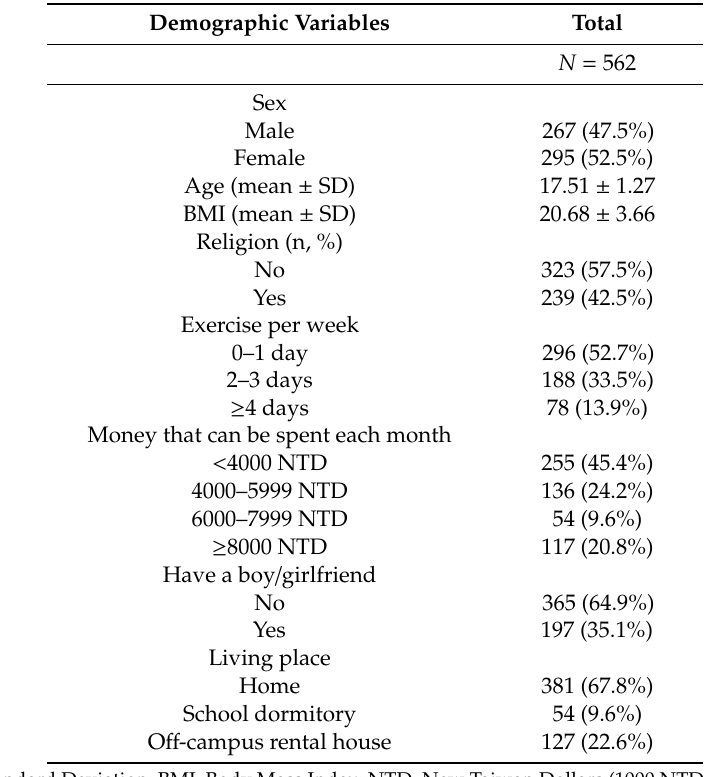
Table 1. Demography of the participants.